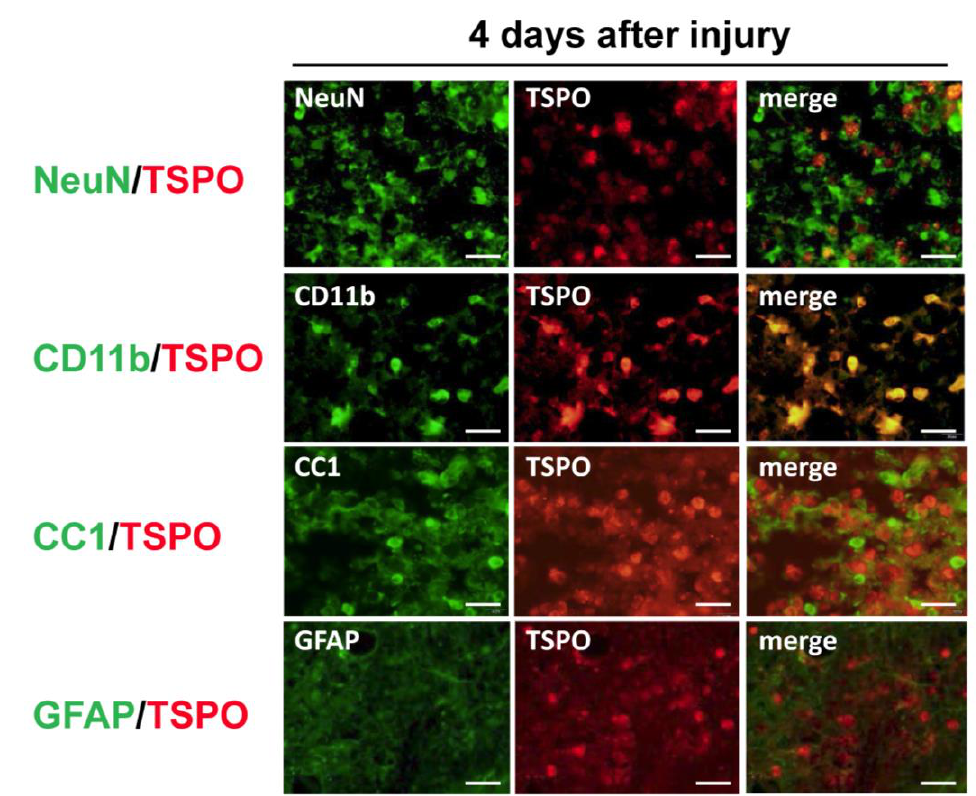
Figure 1. Colocalization of cell-specific markers (NeuN for neurons, CD11b for microglia/macrophages, CC1 for oligodendrocytes and GFAP for astrocytes) and translocator protein 18 kDa (TSPO) in the injured spinal cord at 4 days after spinal cord injury. Most TSPO merged with CD11b, a marker of activated microglia and/or macrophages. TSPO did not colocalize with markers for neurons, oligodendrocytes, and astrocytes. Scale bars = 20 μm.